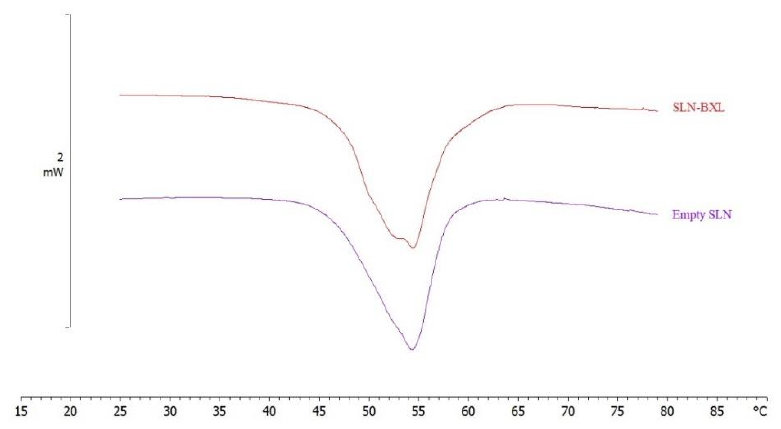
Figure 7. Calorimetric curves, in heating mode, of SLN and